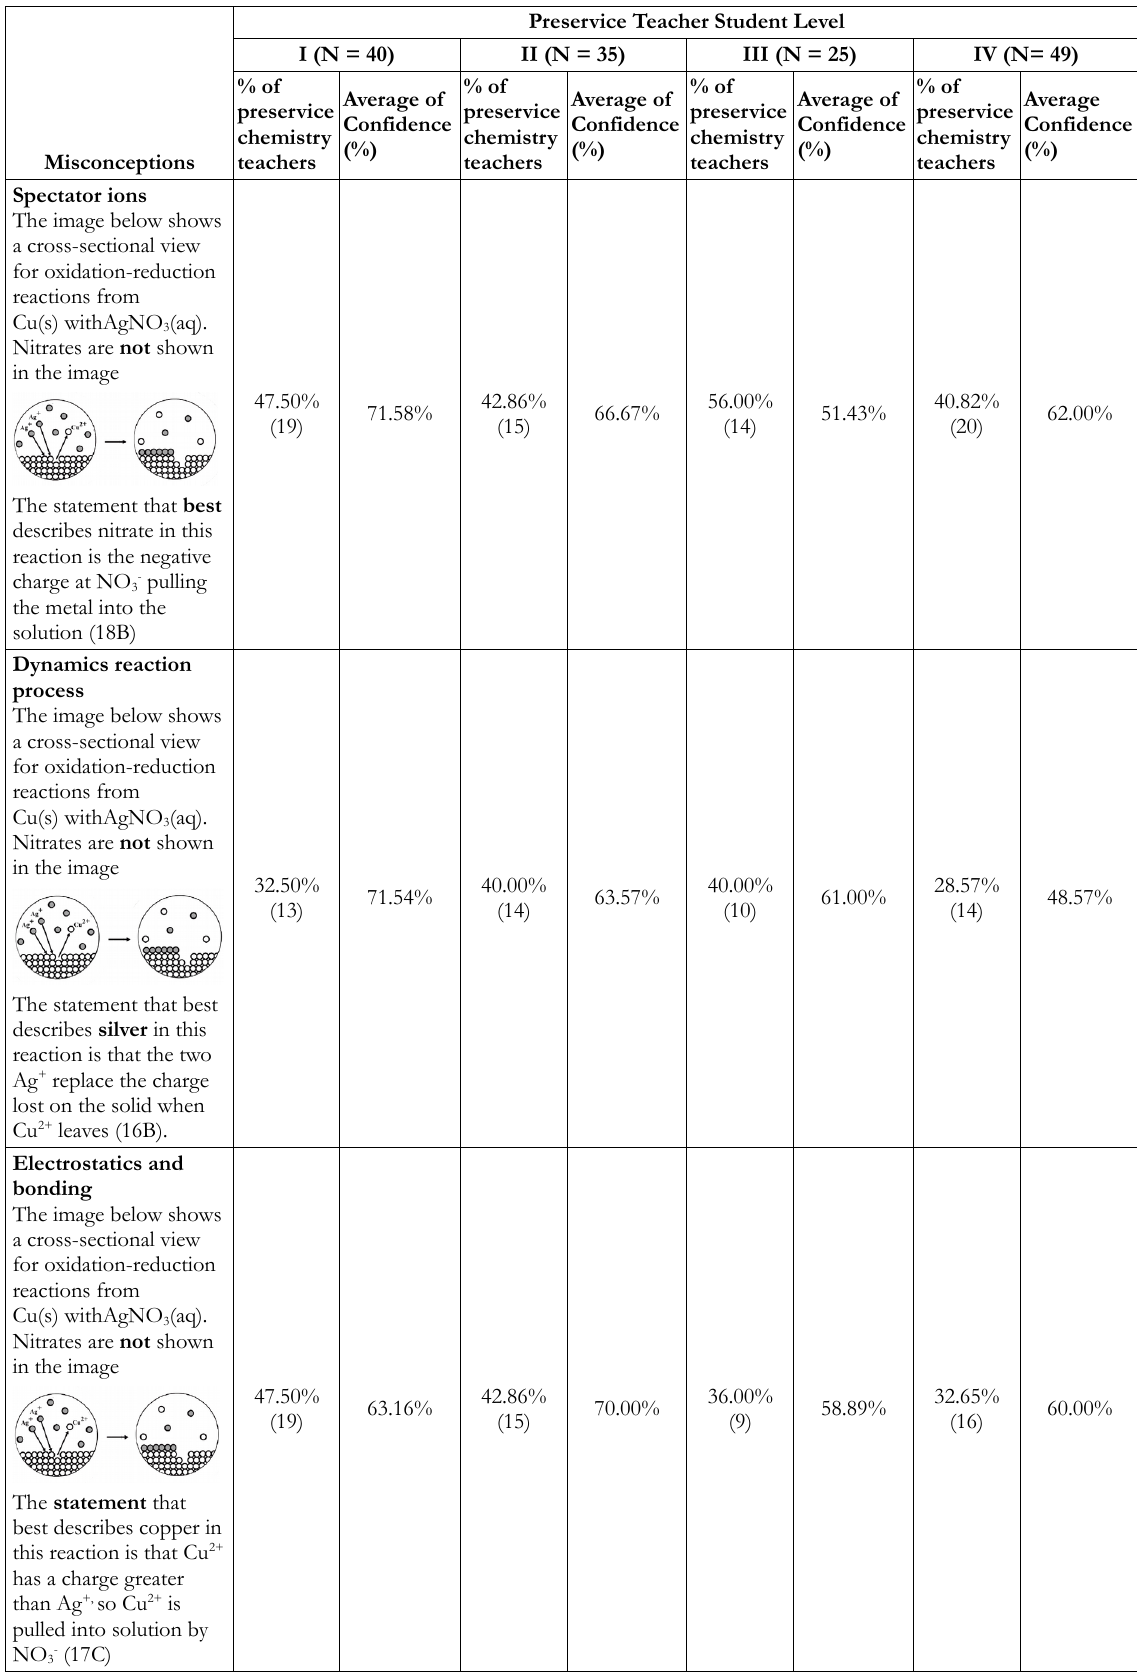
Table 9. Examples of Misconception Percentage and Average